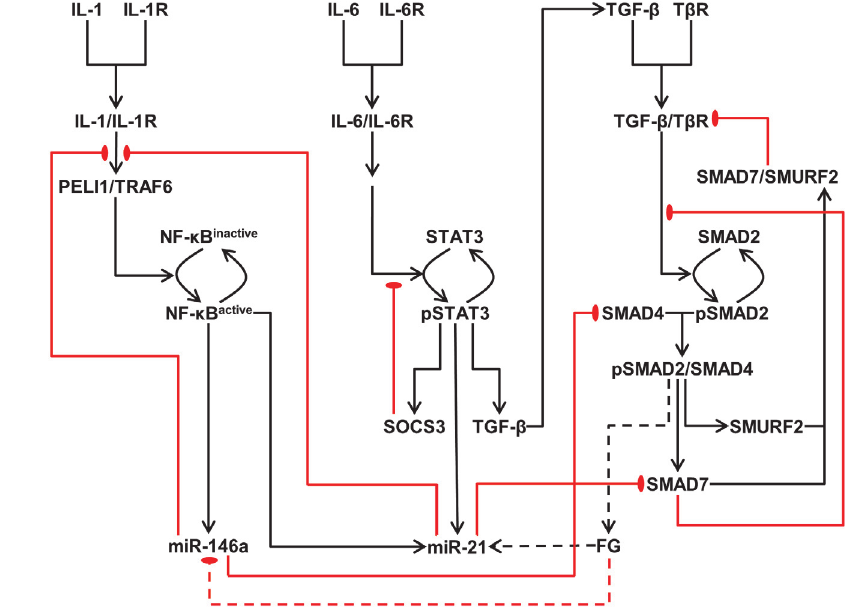
Figure 2. Schematic view of the integrated network model of signaling pathways and microRNA regulatory interactions. Black lines represent activating interactions, while red lines represent inhibitory interactions. Hypothesized interactions are represented by dashed lines.